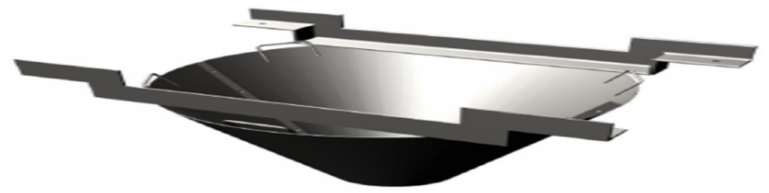
Figure 13. Truncated conical-shaped crowder [19].